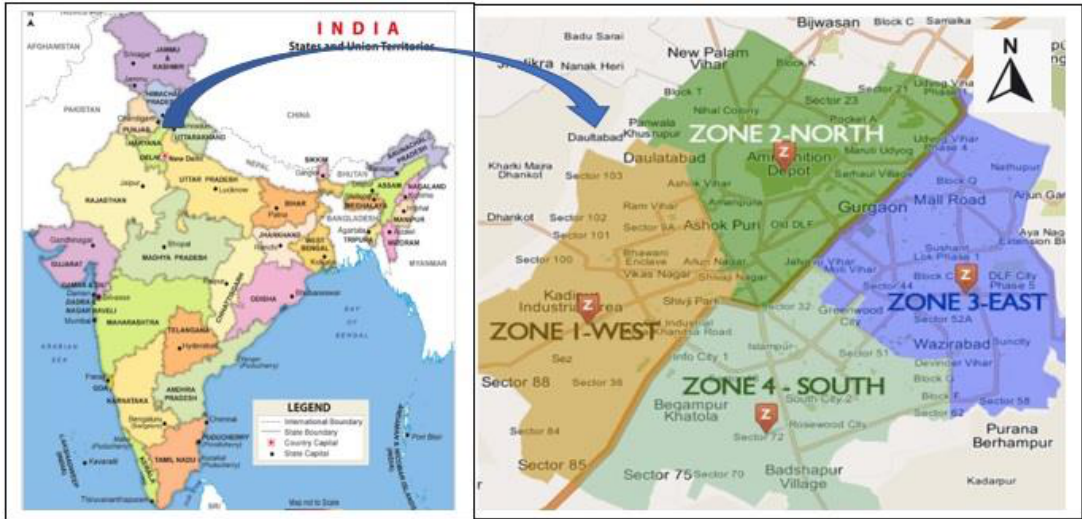
Fig. 1: Geographic location of the study area in Gurugram India